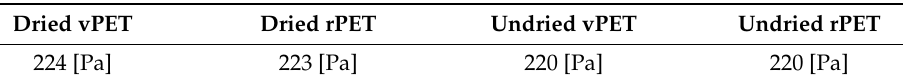
Figure 7. Shear stress curves of the relaxation test.